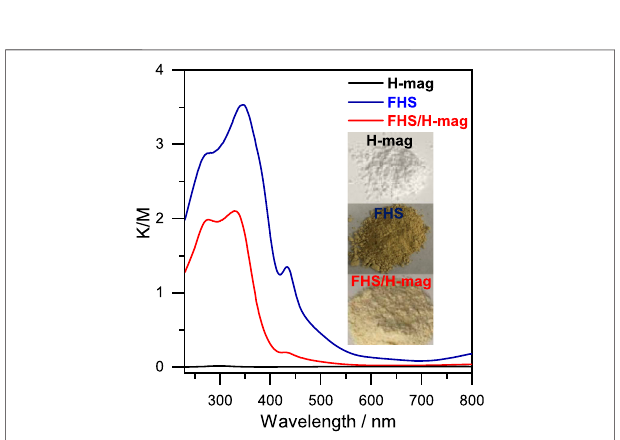
FIGURE 4 | UV-Vis spectra of H-mag, FHS and FHS/H-mag. Inset shows the photographs of each powder.